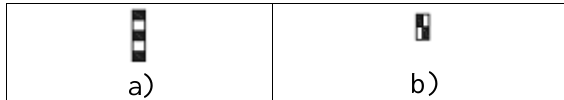
Fig 7. Topographic sign of a pole: (a) not zoomed, (b) zoomed free times 8. Ryškumas . Visi sutartin į ženkl ą sudarantys geometriniai elementai tur ė t ų b ū ti vienodo ryškumo, vienodo storio.